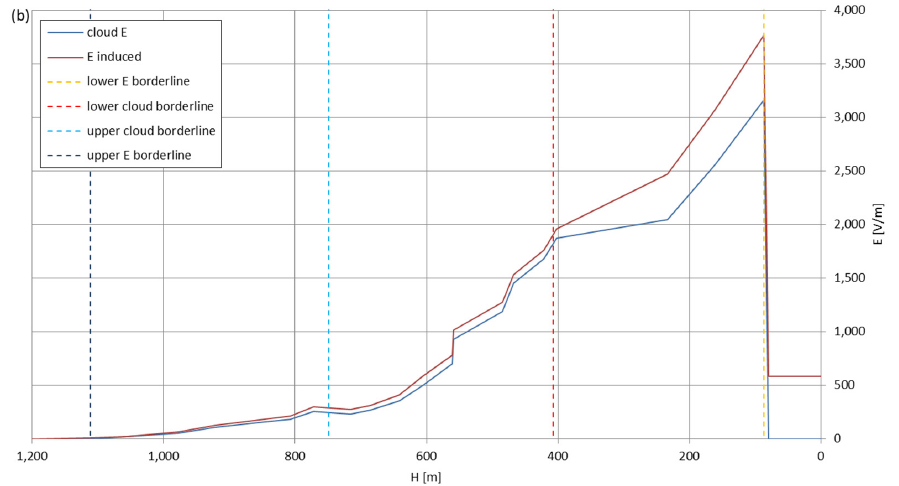
Figure 13. Maximum electric field strengths around the wire antenna re-entering through Stratocumulus cloud positively polarized: ( a ) ‘static’ case and ( b ) ‘dynamic’ case.